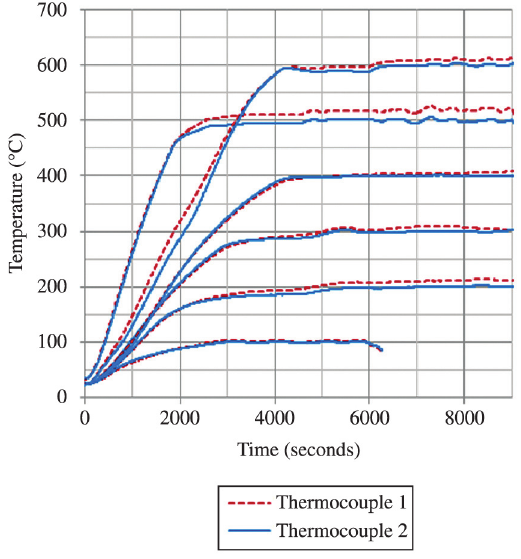
Figure 4. Temperature variations of the specimens as a function of time in seconds.